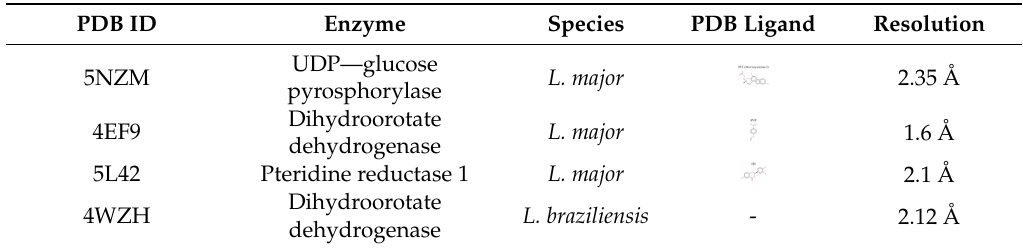
Table 13. Information regarding the selected enzymes deposited in the PDB database and used for docking